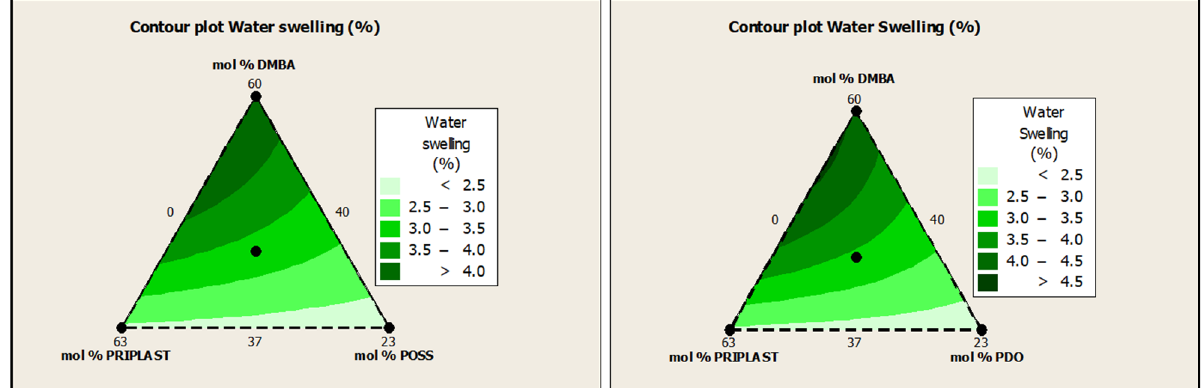
Figure 16. Contour plots of water swelling in wt.% of ternary mixture experimental design with POSS-OH ( left ) and PDO ( right ).